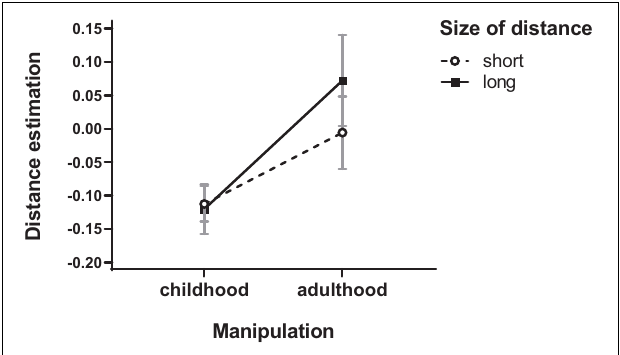
FIGURE 1 | Effects of childhood priming on distance assessment. Error bars represent standard errors of the